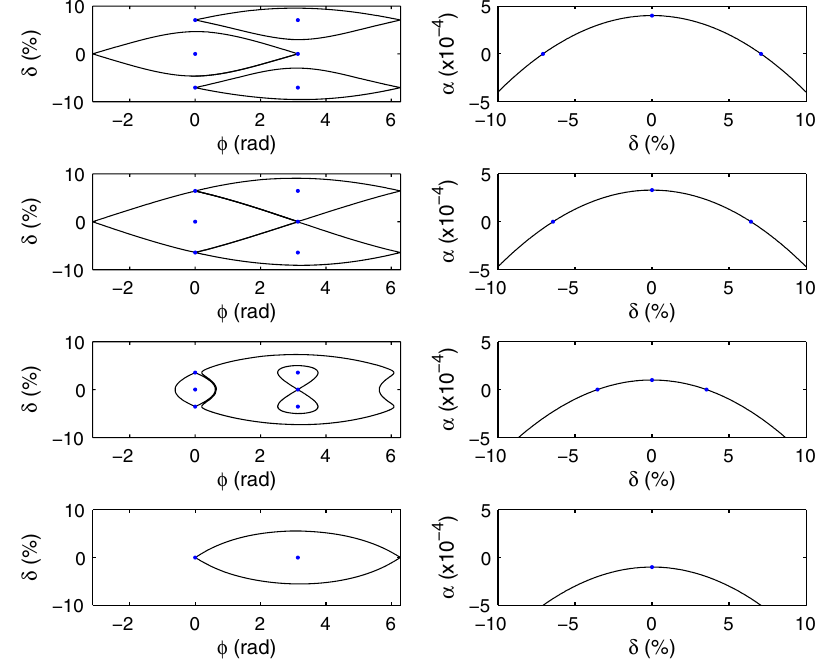
FIG. 1. Figure showing how the separatrices between stable and unstable motion vary as (cid:3) 1 is reduced from positive to negative values for the case where ’ s ¼ 0 , (cid:3) 2 ¼ 0 , and (cid:3) 3 < 0 . The right-hand plots show the corresponding values for alpha. The four stages illustrated are rf-bucket regime (top), transition (middle top), alpha-bucket regime (middle bottom), and negative alpha